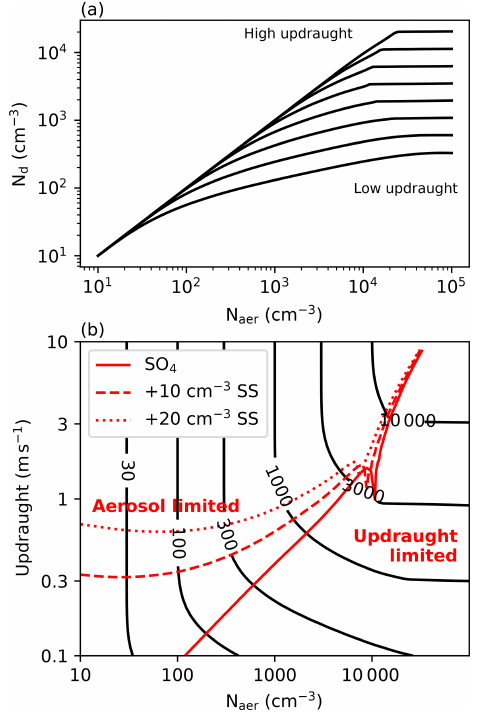
Figure 4. (a) The relationship between aerosol number ( N aer ) and droplet number concentration ( N d ) for a selection of updraught speeds. Black lines are N d contours. The aerosol is a monodis- perse ammonium sulfate with a mean radius of 40nm. (b) The N d as a function of aerosol number and updraught speed for the same monodisperse aerosol. Red contours show the boundary between aerosol-limited and updraught-limited regions. Dashed and dotted red contours show the location of this boundary with the introduc- tion of 10 and 20cm − 3 for 850nm background sea salt (SS)